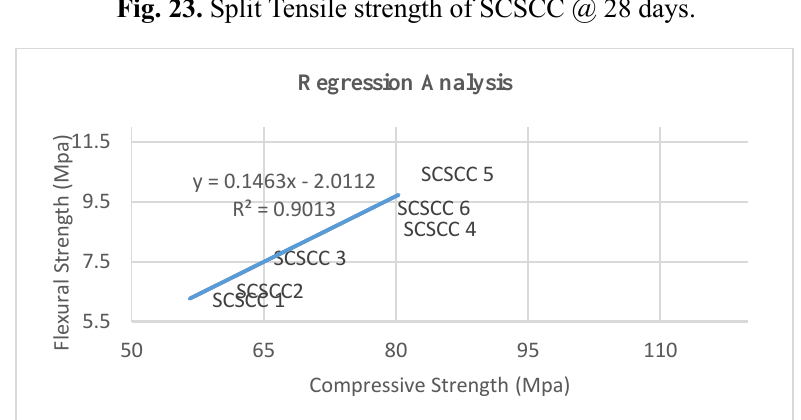
Fig. 23. Split Tensile strength of SCSCC @ 28 days.